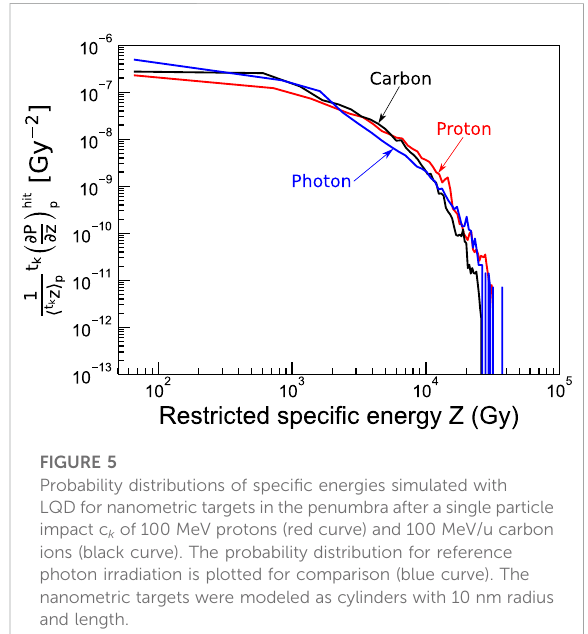
FIGURE 5 Probability distributions of speci fi c energies simulated with LQD for nanometric targets in the penumbra after a single particle impact c k of 100 MeV protons (red curve) and 100 MeV/u carbon ions (black curve). The probability distribution for reference photon irradiation is plotted for comparison (blue curve). The nanometric targets were modeled as cylinders with 10 nm radius and length.